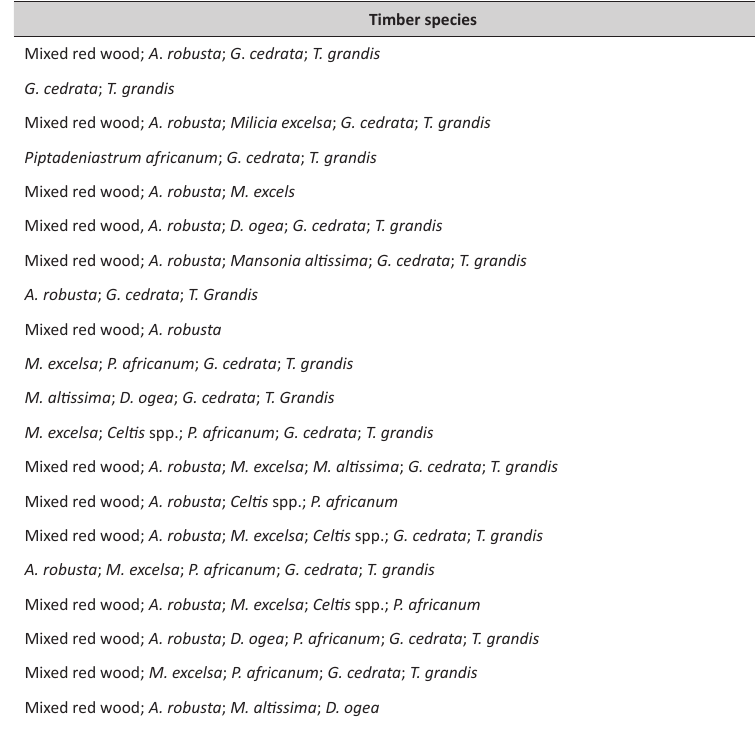
TaBLe 2. Timber species used by firms for furniture production Timber species respondents/Firms (%) Mixed red wood; A . robusta ; G . cedrata ; T.